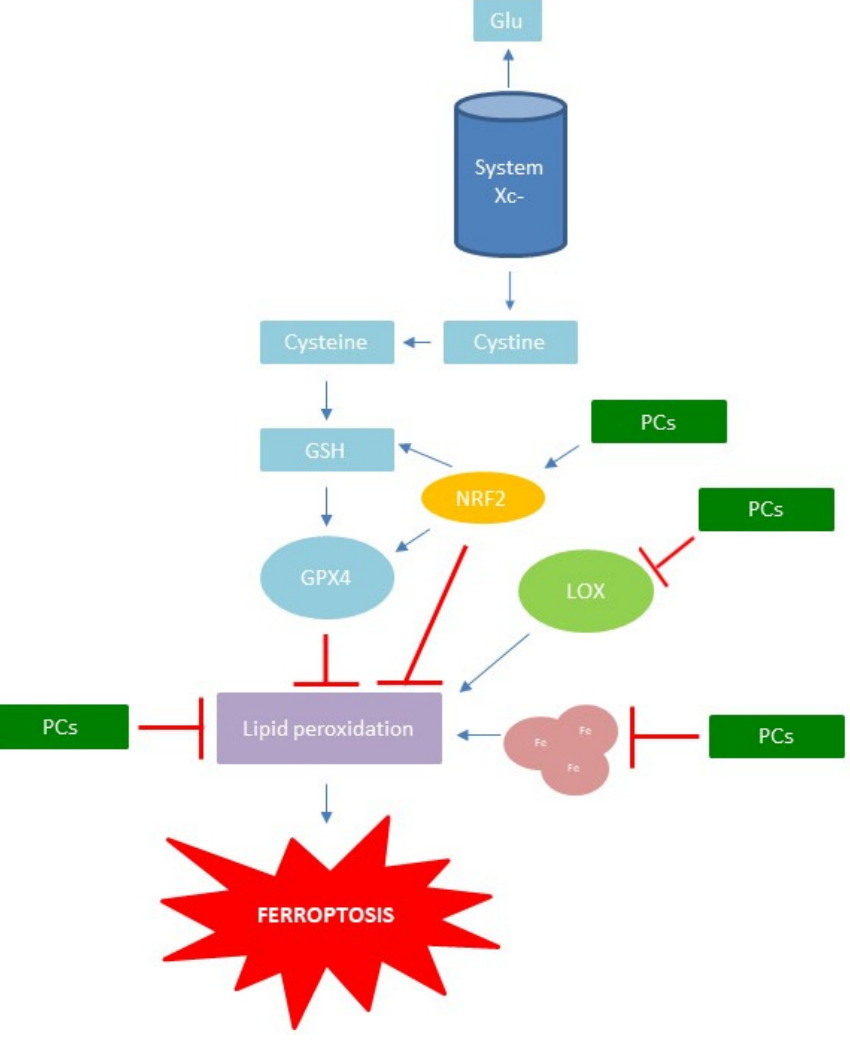
Figure 5. Mechanisms of ferroptosis inhibition by PCs.